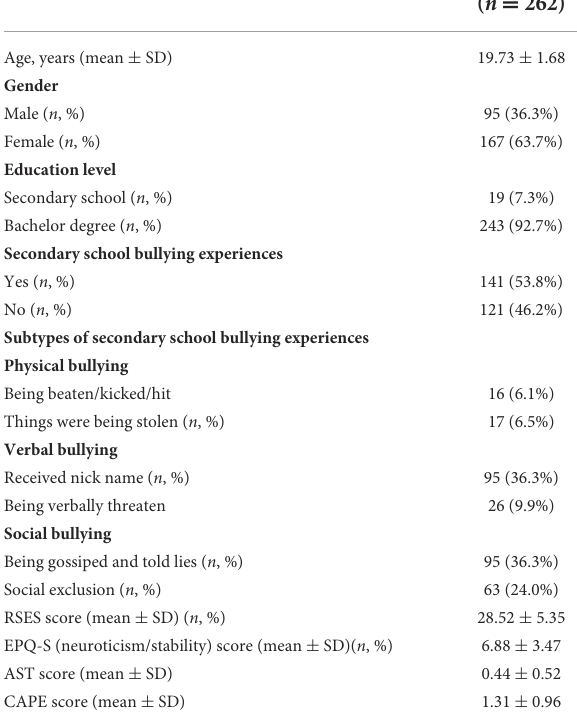
TABLE 1 Characteristics of all